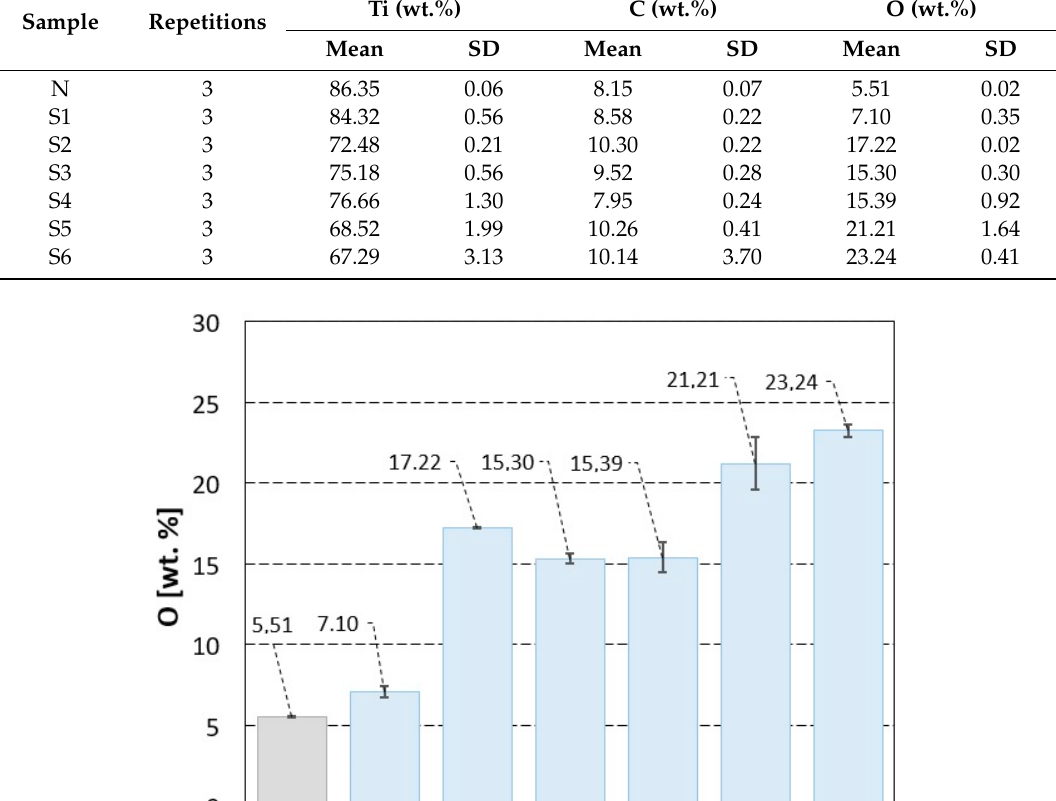
Table 3. One-way analysis of variance (ANOVA) results.